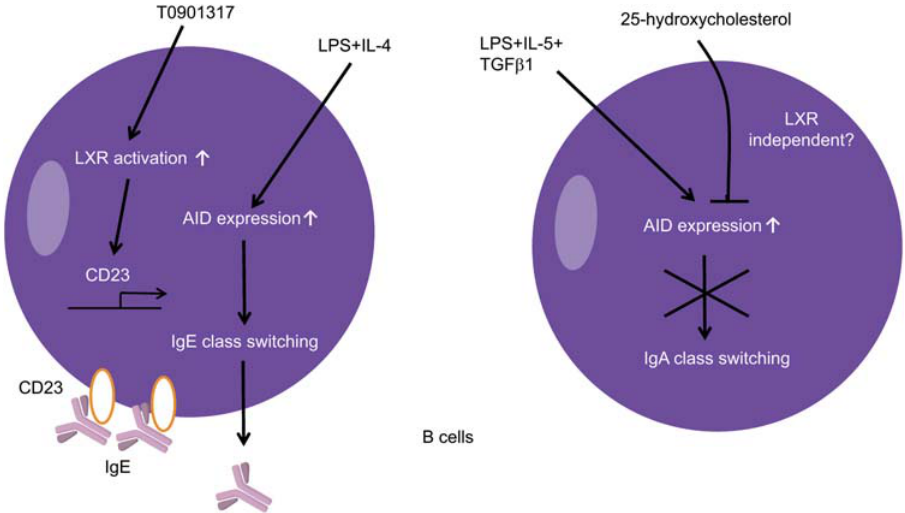
Figure 3 Regulation of immunoglobulin class switching in B cells. Activation of LXR with synthetic ligands inhibits IgE production from B cells by inducing CD23 expression, whereas LXR activation does not alter AID expression and IgE class switching. In contrast, 25-hydroxycholesterol, a naturally occurring oxysterol, suppresses AID expression and IgA class switching. It is unclear whether LXR activation is involved in 25-hydroxycholesterol-mediated suppression of AID expression.